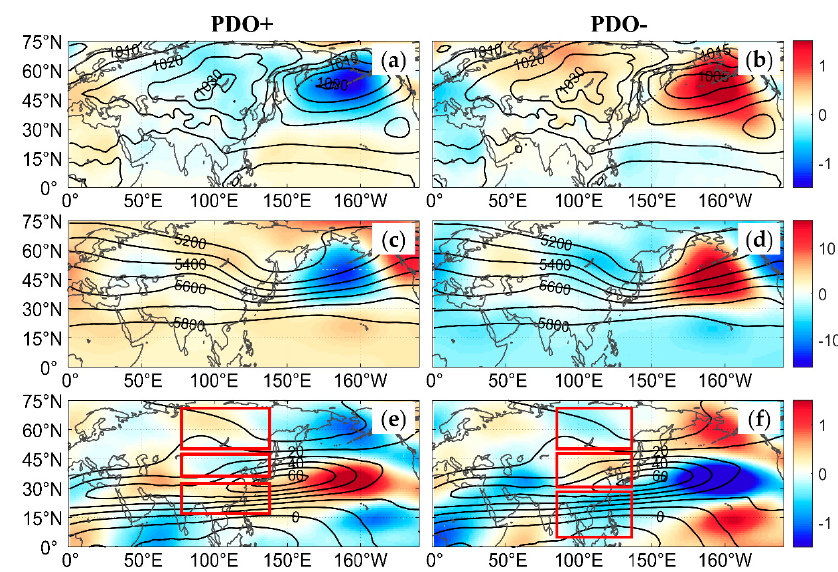
Figure 8. Six-year moving average annual normalized PDO index and CWT. The pink and blue shading represent the positive and negative phases of the PDO, respectively. Grey shading is not classified due to incomplete stages.